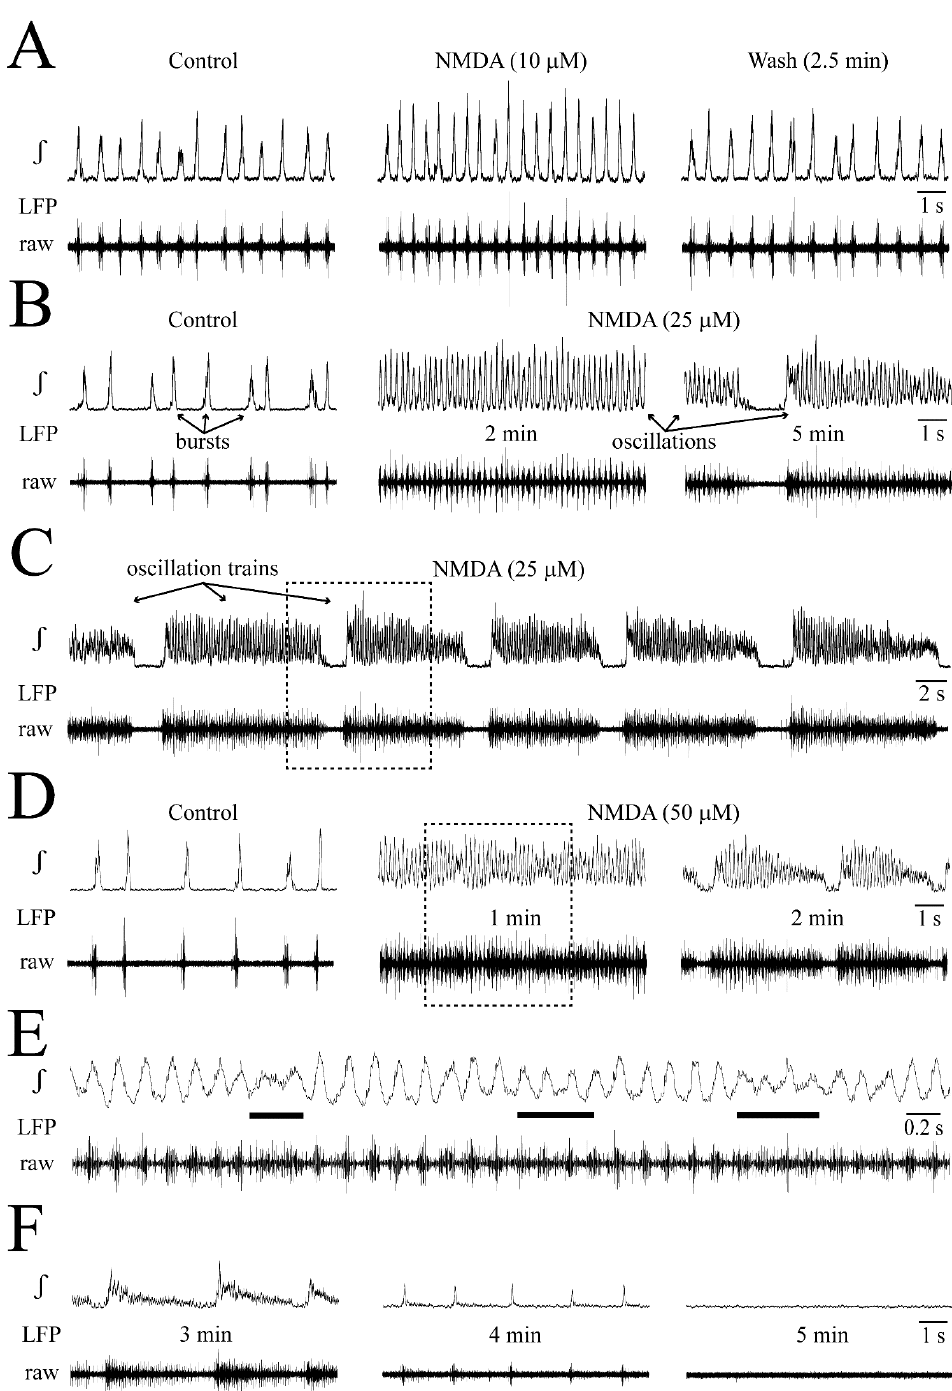
Figure 3. NMDA effects on LFP. ( A ) A dose of 10 µ M NMDA increased LFP rate and shortened its duration. ( B ) At 2 min, 25 µ M NMDA evoked fast ‘oscillations’ with lack of a time period of inactivity between events like in control (compare left and middle panels). At 5 min, oscillations were transiently depressed (right panels). ( C ) Several cycles of resulting ‘oscillation trains’ at lower time resolutions [train in ( B ), indicated by dashed-line box]. Initially, early oscillation and train oscillation rates and durations were similar. However, over several train cycles, oscillation amplitude diminished and rhythm became irregular toward the end of each event. ( D ) At 1 min, 50 µ M caused oscillations similar to those in 25 µ M, though at this time amplitude fluctuations occurred